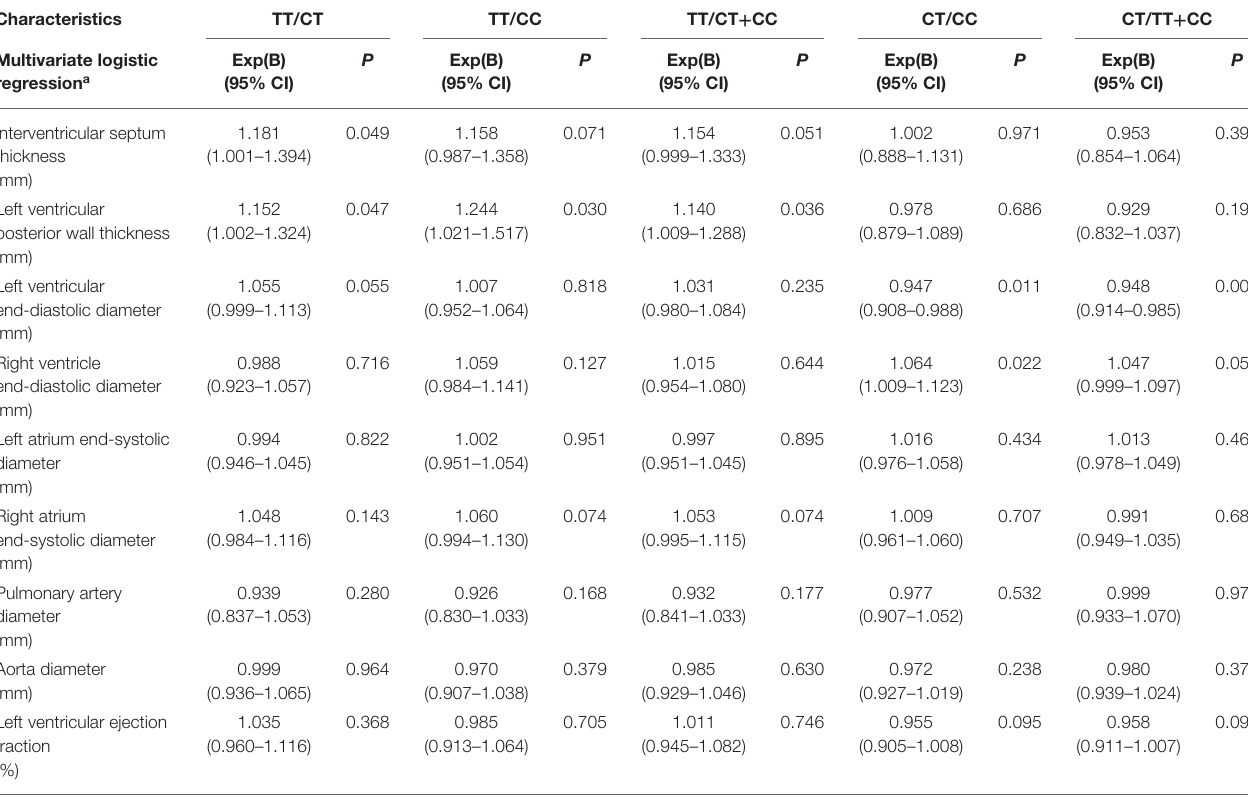
TABLE 4 | Associations of cardiac structure and function with different genotypes of rs189037 in the centenarians.